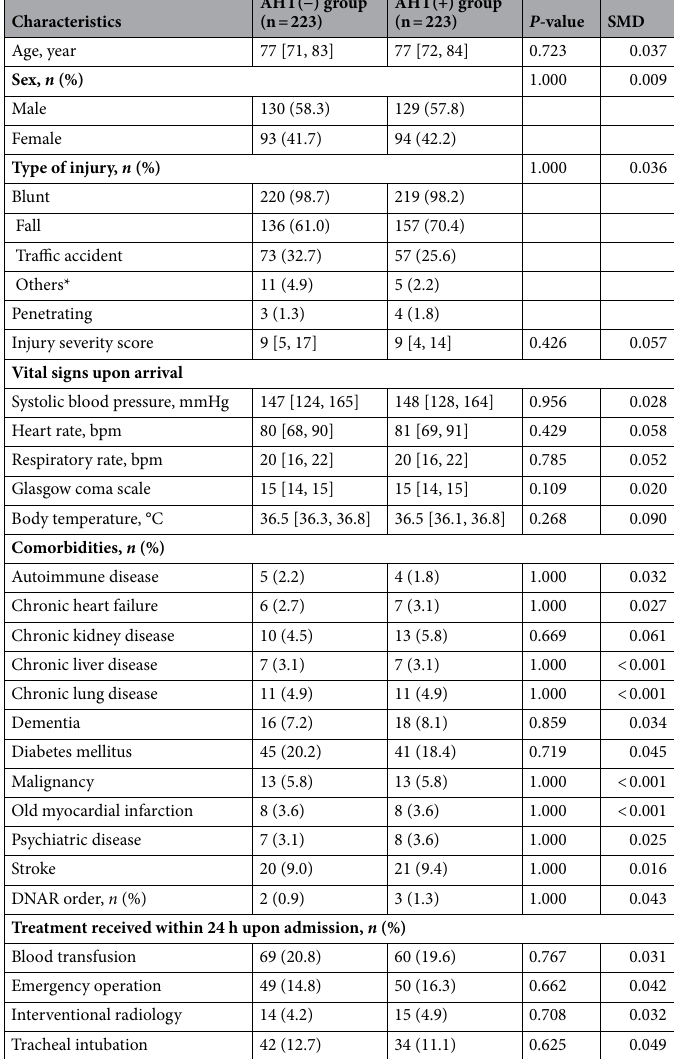
interquartile ranges. The balance between the two groups was evaluated using the SMD; an SMD > 0.1 was considered significant. *Others included crush, sports, animal-related, and abuse. AHT Antihypertensive drug, DNAR Do not attempt resuscitation, SMD Standardised mean